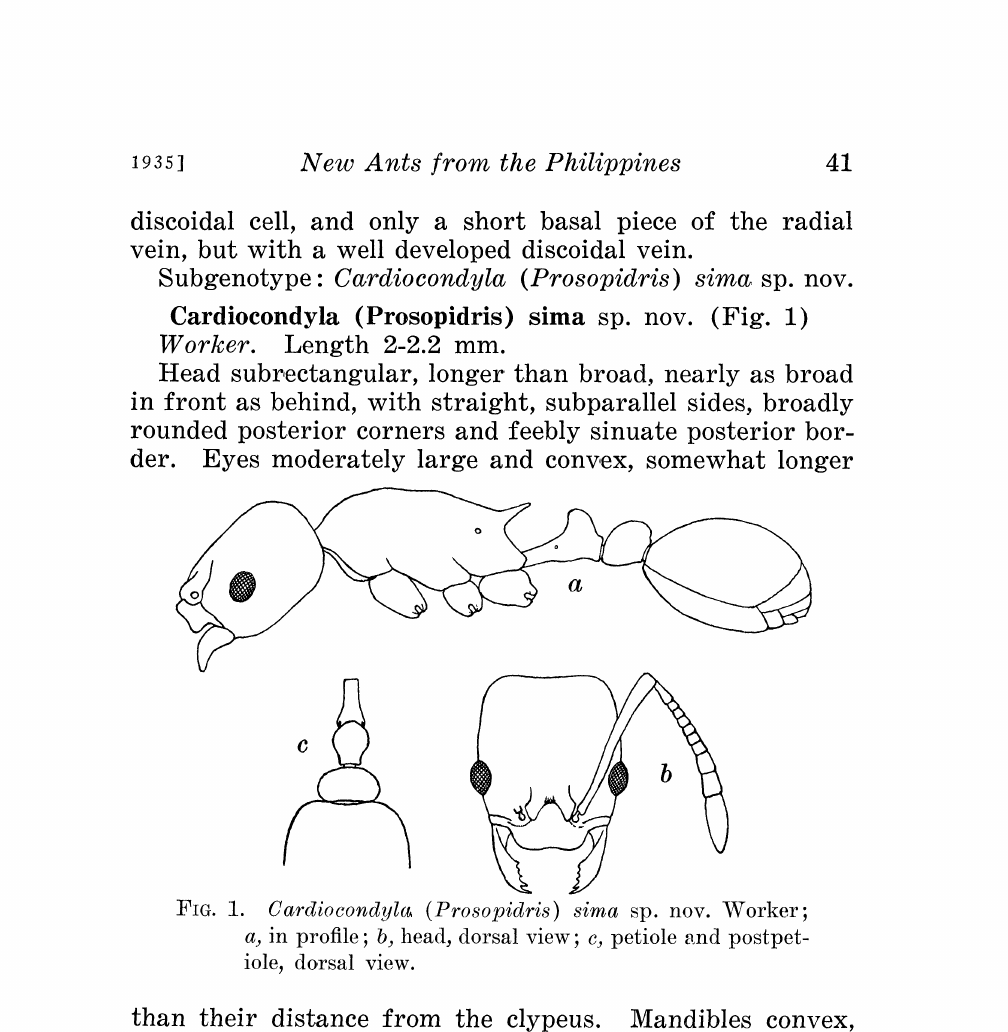
FIG. 1. Cardiocondyh (Prosopidris) sima sp. nov. Worker; a, in profile; b, head, dorsal view; c, petiole and postpet- iole, dorsal